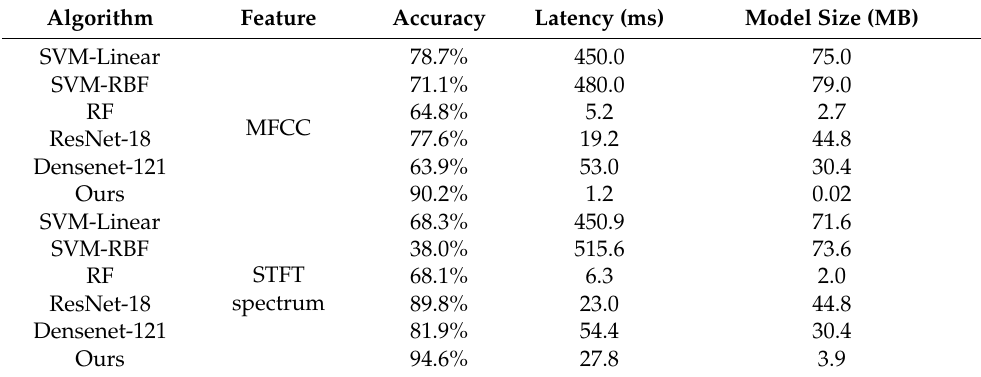
Table 3. Performance of each compared algorithm on the test